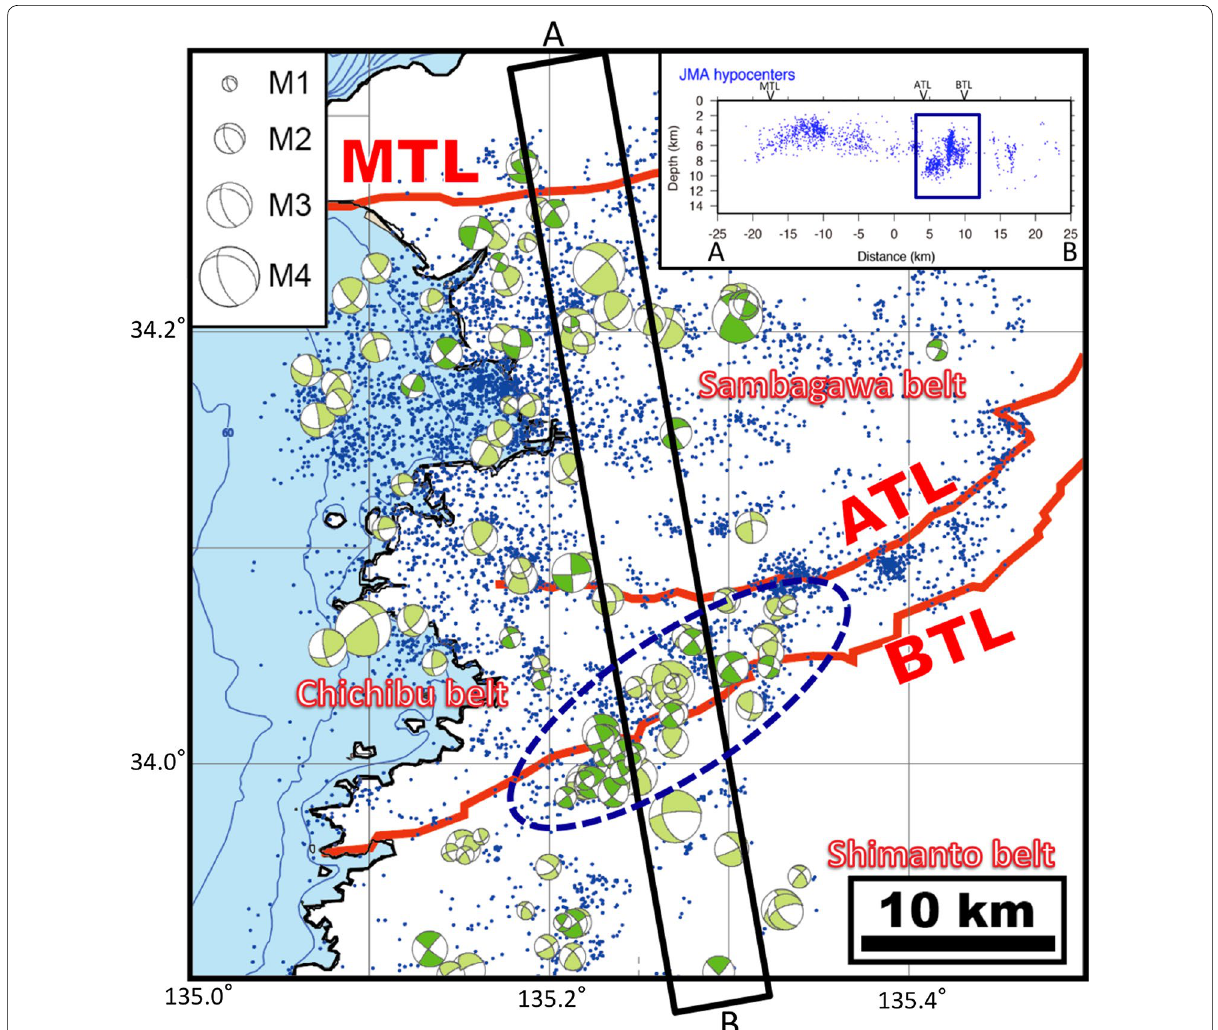
Fig. 11 Strike-slip fault-type focal mechanism distribution in the study area. Almost the same as the right figure in Fig. 5 but normal fault-type and reverse fault-type events are omitted. The events of strike-slip faulting are concentrated close to the Butsuzo Tectonic Line (BTL), indicated by the blue dashed ellipse. The inserted diagram at upper right is a cross section of hypocenter distributions from the JMA catalog for the earthquakes in the long black rectangle in the map. The hypocenters in the blue rectangle in the cross section are aligned vertically, suggesting vertical